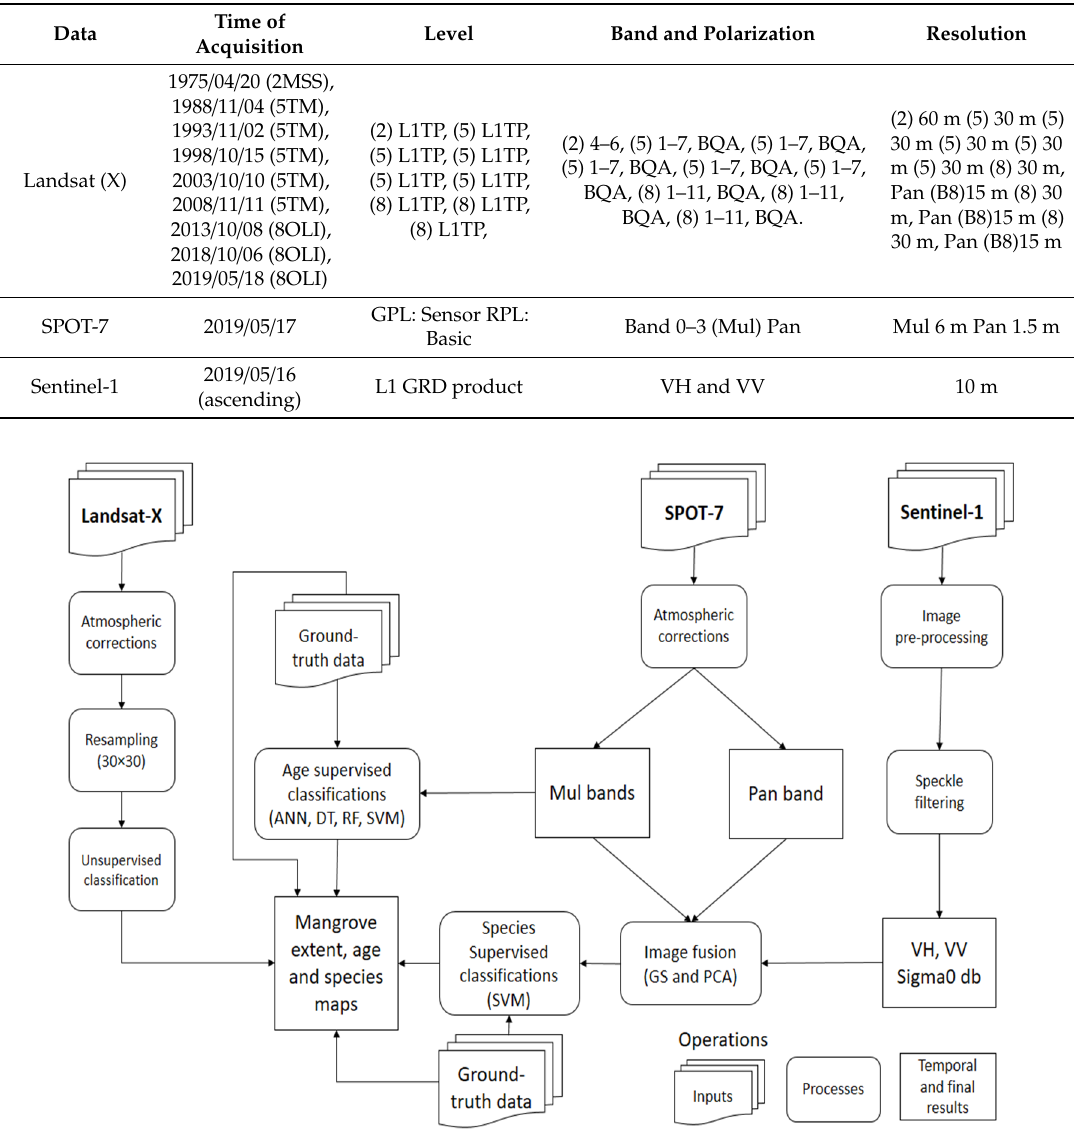
Figure 2. Flowchart of methodology used for mapping mangrove extent, age, and species. X refers to the mission number of the used Landsat images; ANN, DT, RF, SVM stand for artificial neural network, decision tree, random forest, and support vector machine, respectively; Mul and Pan are short forms of multispectral and panchromatic bands, respectively; GS and PCA indicate Gram–Schmidt and principal component analysis image fusion methods; V and H are vertical and horizontal, respectively, and coupled letters of VH and VV indicate Synthetic Aperture Radar (SAR) cross-polarizations.